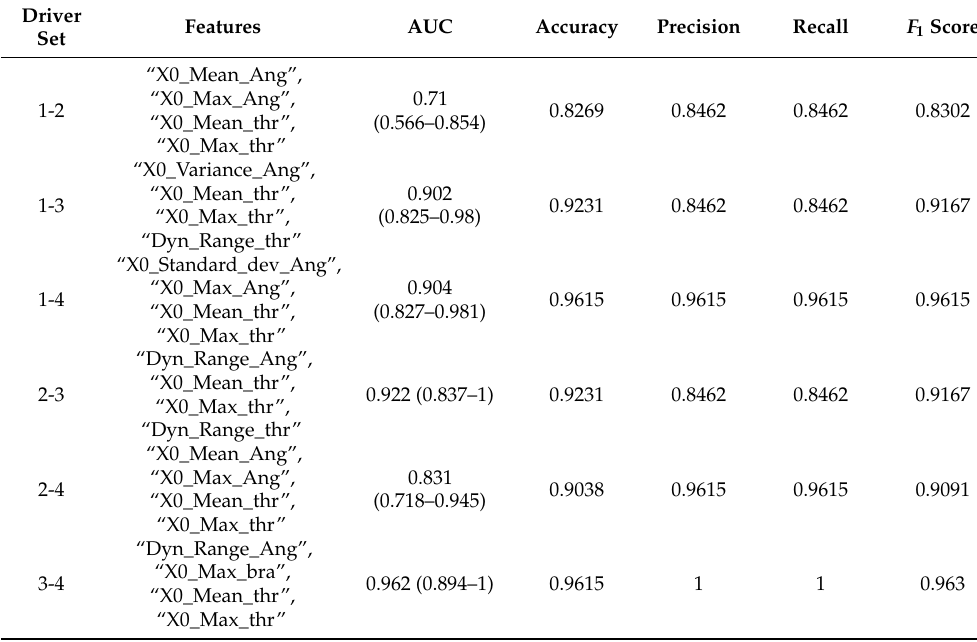
Table 4. RFE selection with Random Forest model implementation